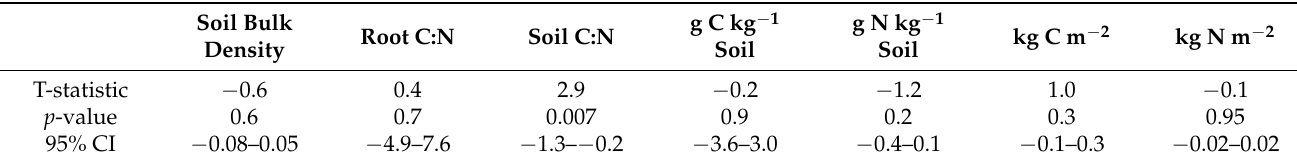
Table 2. Paired t -test results for changes in soil and root properties from 2008 to 2018 in sampling transects at Midewin for 0–10 cm soil layer.